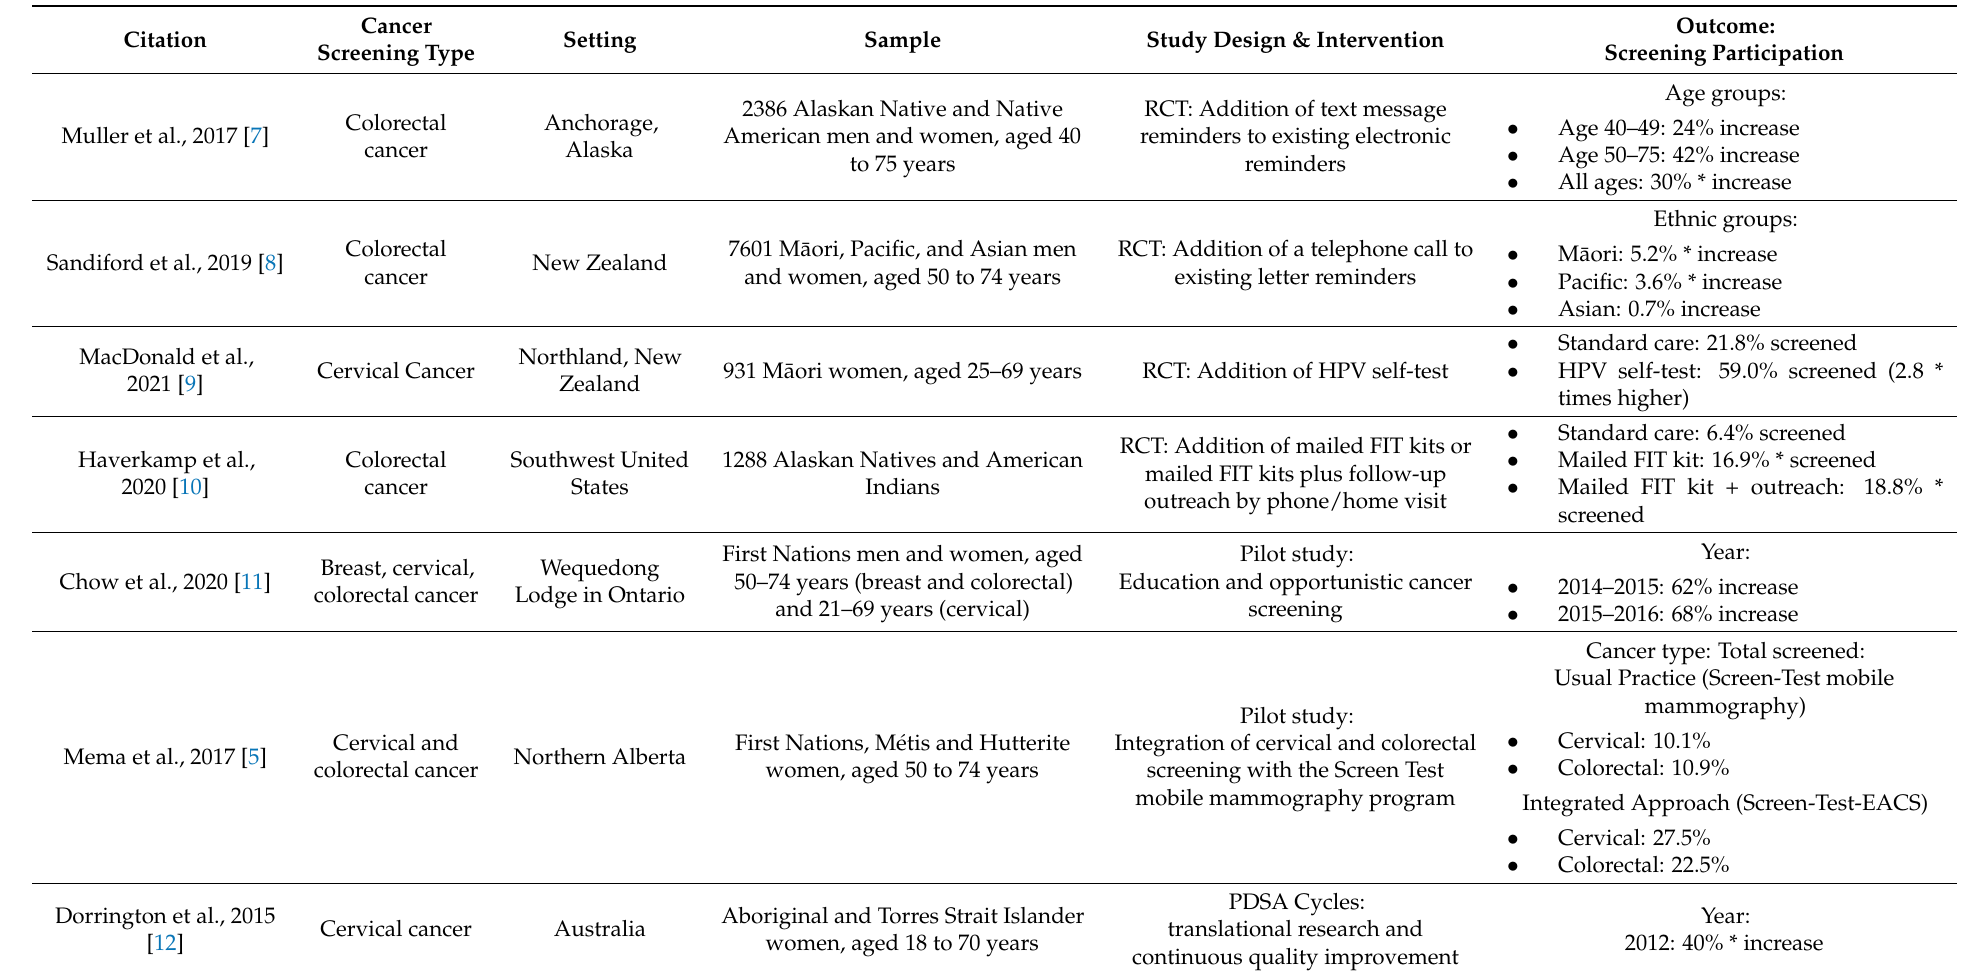
Table 3. Interventions that increased screening